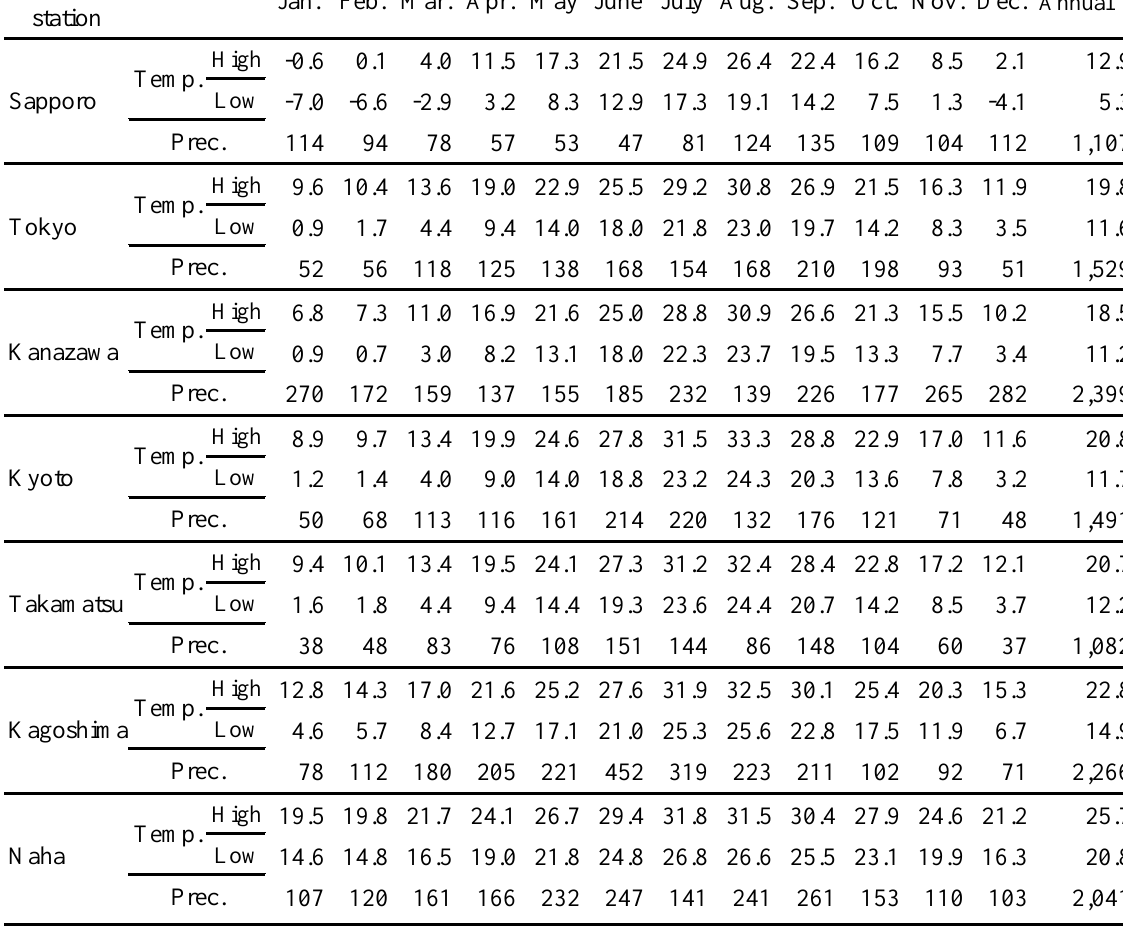
Temperature ( ℃ ) Precipitation